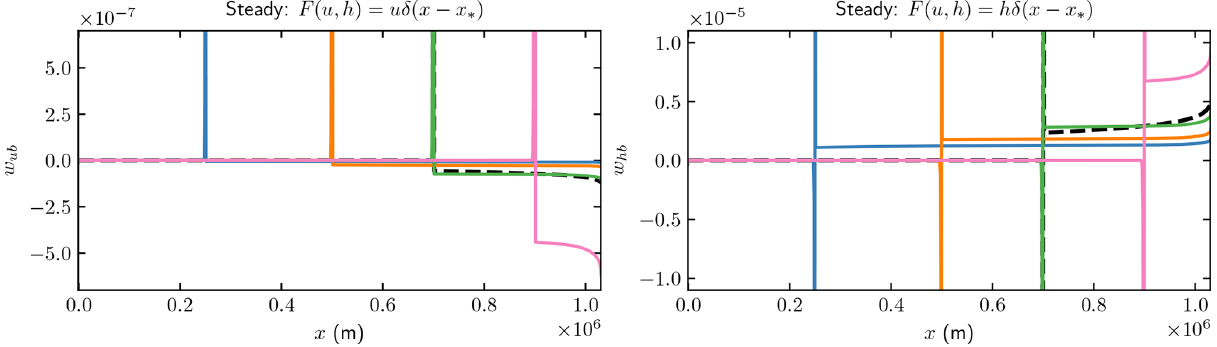
Figure 8. A close-up view of the steady-state weights in the lower panels of Fig.